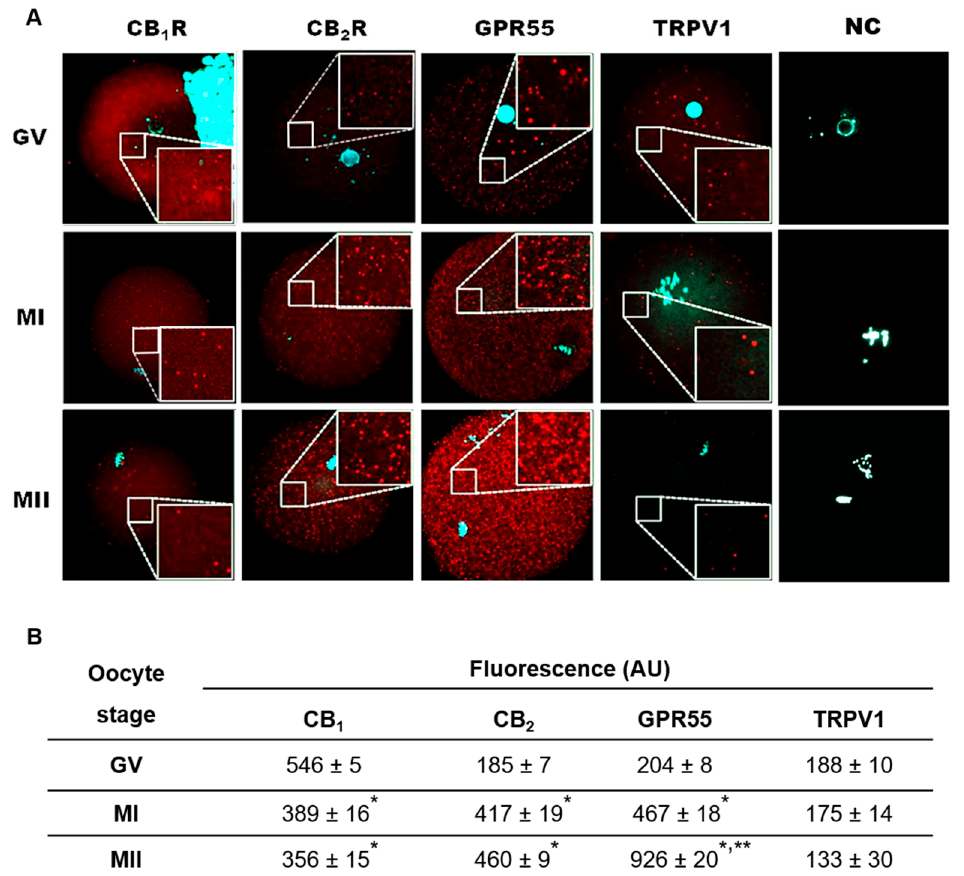
Figure 2. ( A ) Localization of CB 1 R, CB 2 R, GPR55, and TRPV1 receptors in mouse oocytes collected at various stages of in vivo meiotic maturation. Receptors were labelled with Cy-3 (red), DNA was counterstained by DAPI (cyan). In the upper right-hand corner of GV CB 1 R, the strong DAPI staining is due to undetached cumulus cell nuclei. Each image was taken at the equatorial plan of the oocyte. Magnification: ×630. Each inset represents a magnified part of ooplasm. GV = germinal vesicle; MI= metaphase I; MII= metaphase II; NC= negative control. ( B ) Mean fluorescence of CB 1 R, CB 2 R, GPR55, and TRPV1 receptors in mouse oocytes collected at different stages of meiotic maturation. Values are expressed as arbitrary units (AU) and are reported as mean ± SEM of 6 oocytes from 3 independent experiments. * p < 0.05 vs. GV oocyte of the same experimental group; ** p < 0.05 vs. MI of the same experimental group.